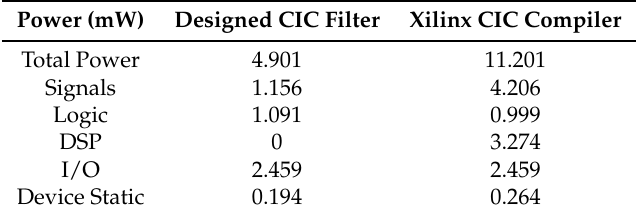
Table 5. Power consumption comparison. Designed CIC Filter vs. IP core.